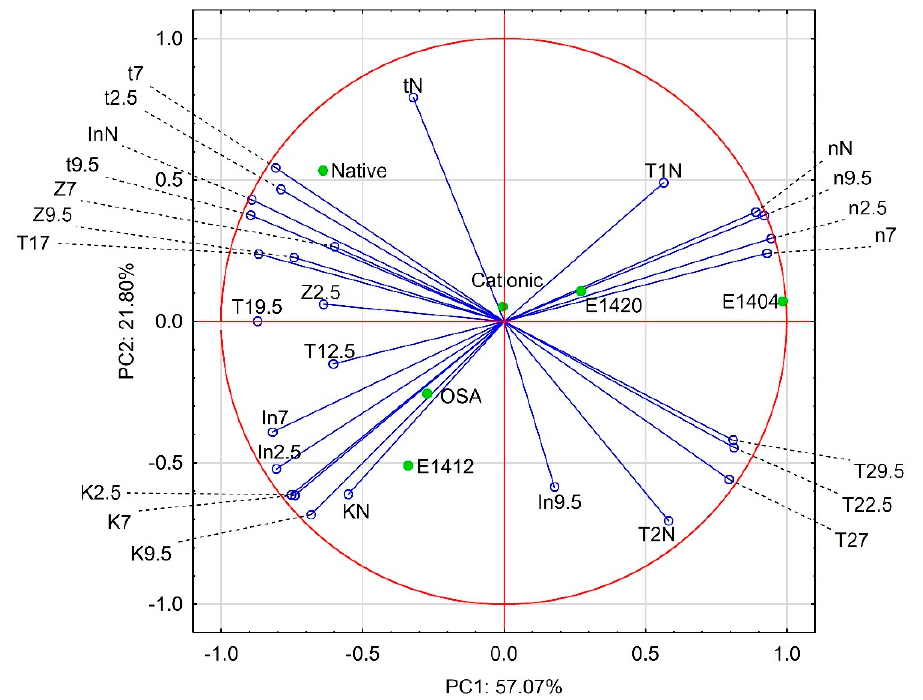
Figure 1. Principal Components Analysis of the data presented in the study; Explanatory notes: K2.5; K7; K9.5; KN–consistency indexes at pH 2.5; 7.0; 9.5 and without pH regulation, respectively; n2.5; n7; n9.5; nN flow behaviour indexes at pH 2.5; 7.0; 9.5 and without pH regulation, respectively; T12.5; T17; T19.5; T1N–spin-lattice relaxation times at pH 2.5; 7.0; 9.5 and without pH regulation, respectively; T22.5; T27; T29.5; T2N–spin-spin relaxation times at pH 2.5; 7.0; 9.5 and without pH regulation, respectively; t2.5; t7; t9.5; tN–mean correlation times at pH 2.5; 7.0; 9.5 and without pH regulation, respectively; Z2.5; Z7; Z9.5– ζ potential values at pH 2.5; 7.0; and 9.5, respectively; In2.5; In7; In9.5; InN–intensity weighted mean hydrodynamic diameter at pH 2.5; 7.0; 9.5 and without pH regulation, respectively.